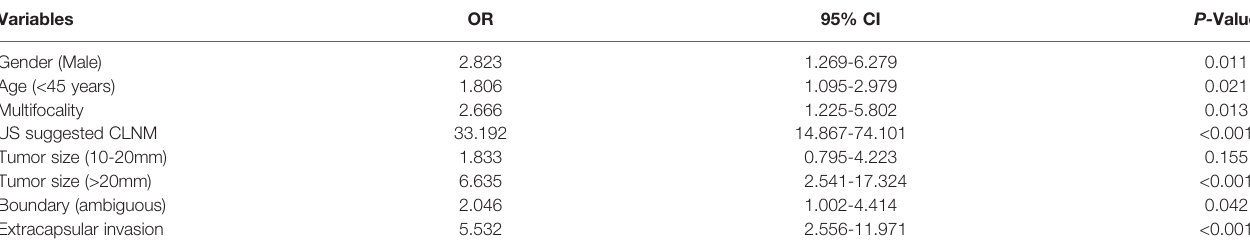
TABLE 3 | Multivariate analysis of predictive factors associated with CLNM in PTC